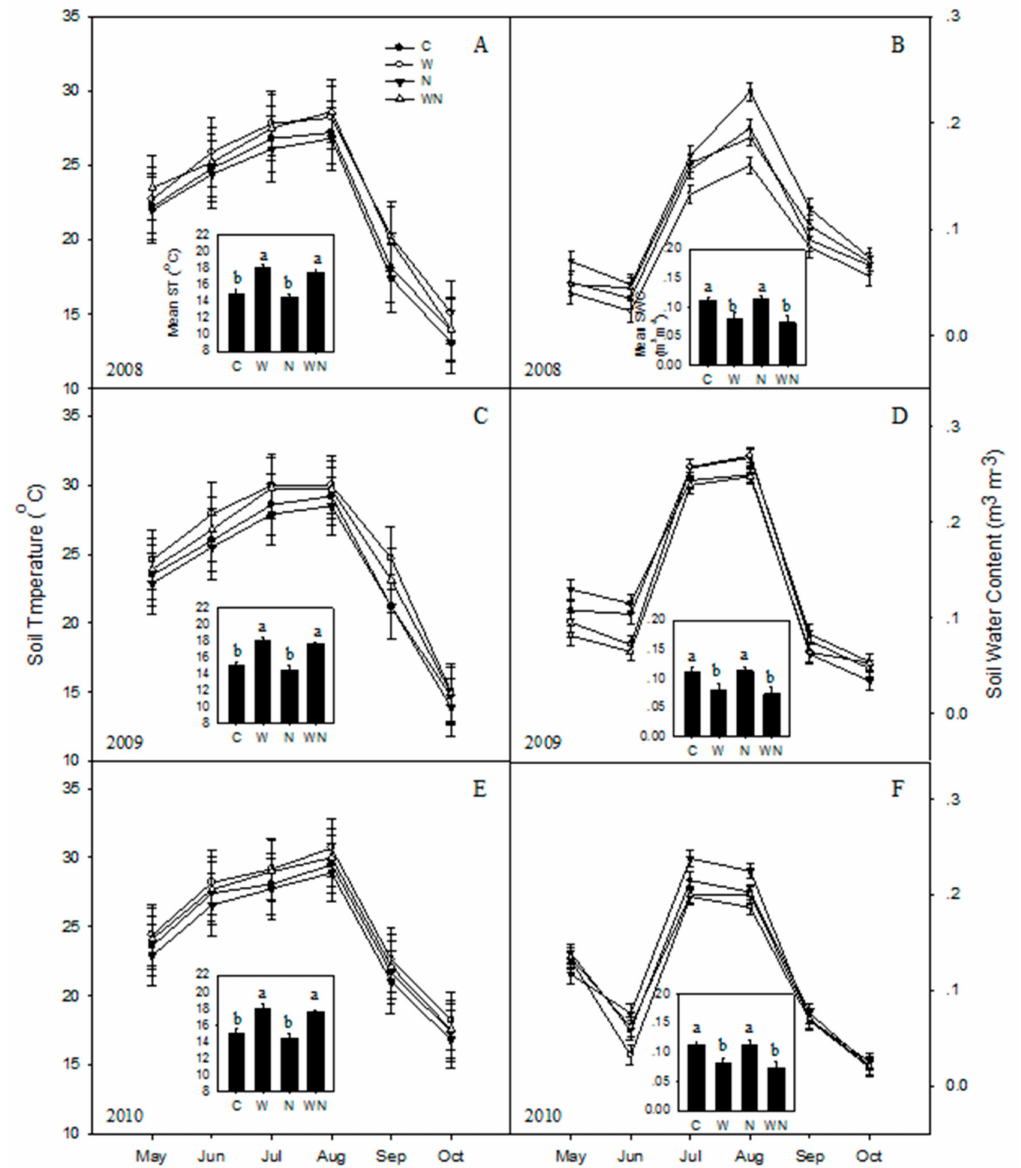
Figure 2. Seasonal variations of soil temperature ( A : 2008, C : 2009, E : 2010) and water content ( B : 2008, D : 2009, F : 2010) in response to warming and N addition. C: Control; W: Warming; N: N addition; WN: Warming plus N addition. Vertical bars indicate standard error of the mean (n = 6). Di ff erent lowercase letters indicate significant di ff erences ( P <